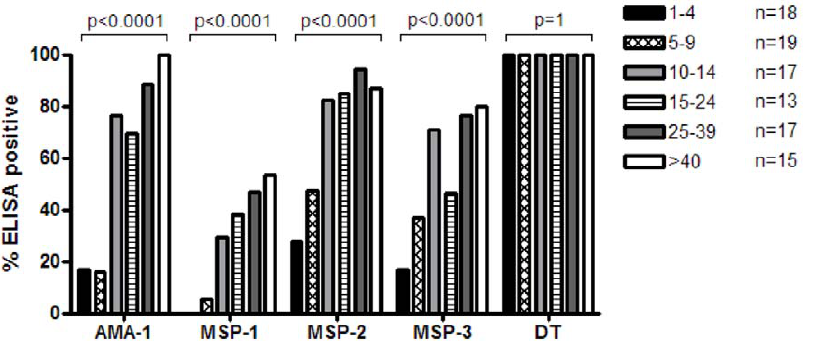
Figure 1. The proportion of individuals with malaria-specific plasma antibodies increases with age. The percentage of individuals having Ab levels above the cut-off for AMA-1, MSP-1 19 , MSP-2, MSP-3 or DT are shown for each age group. Data are for samples collected in May– June 2009, prior to the annual malaria transmission season. N is equal to the number of samples available per age group. P values indicate the result for the Chi-squared test for trend.